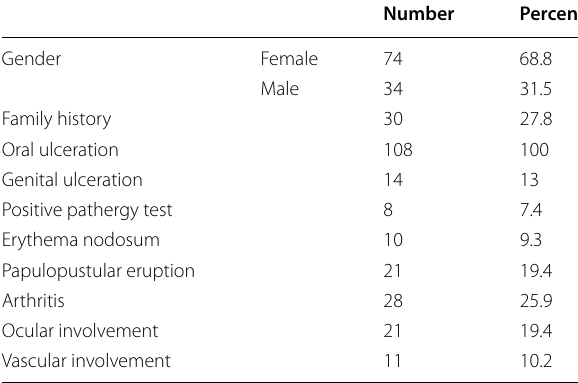
Table 1 Demographic and clinical profiles of the Behçet’s